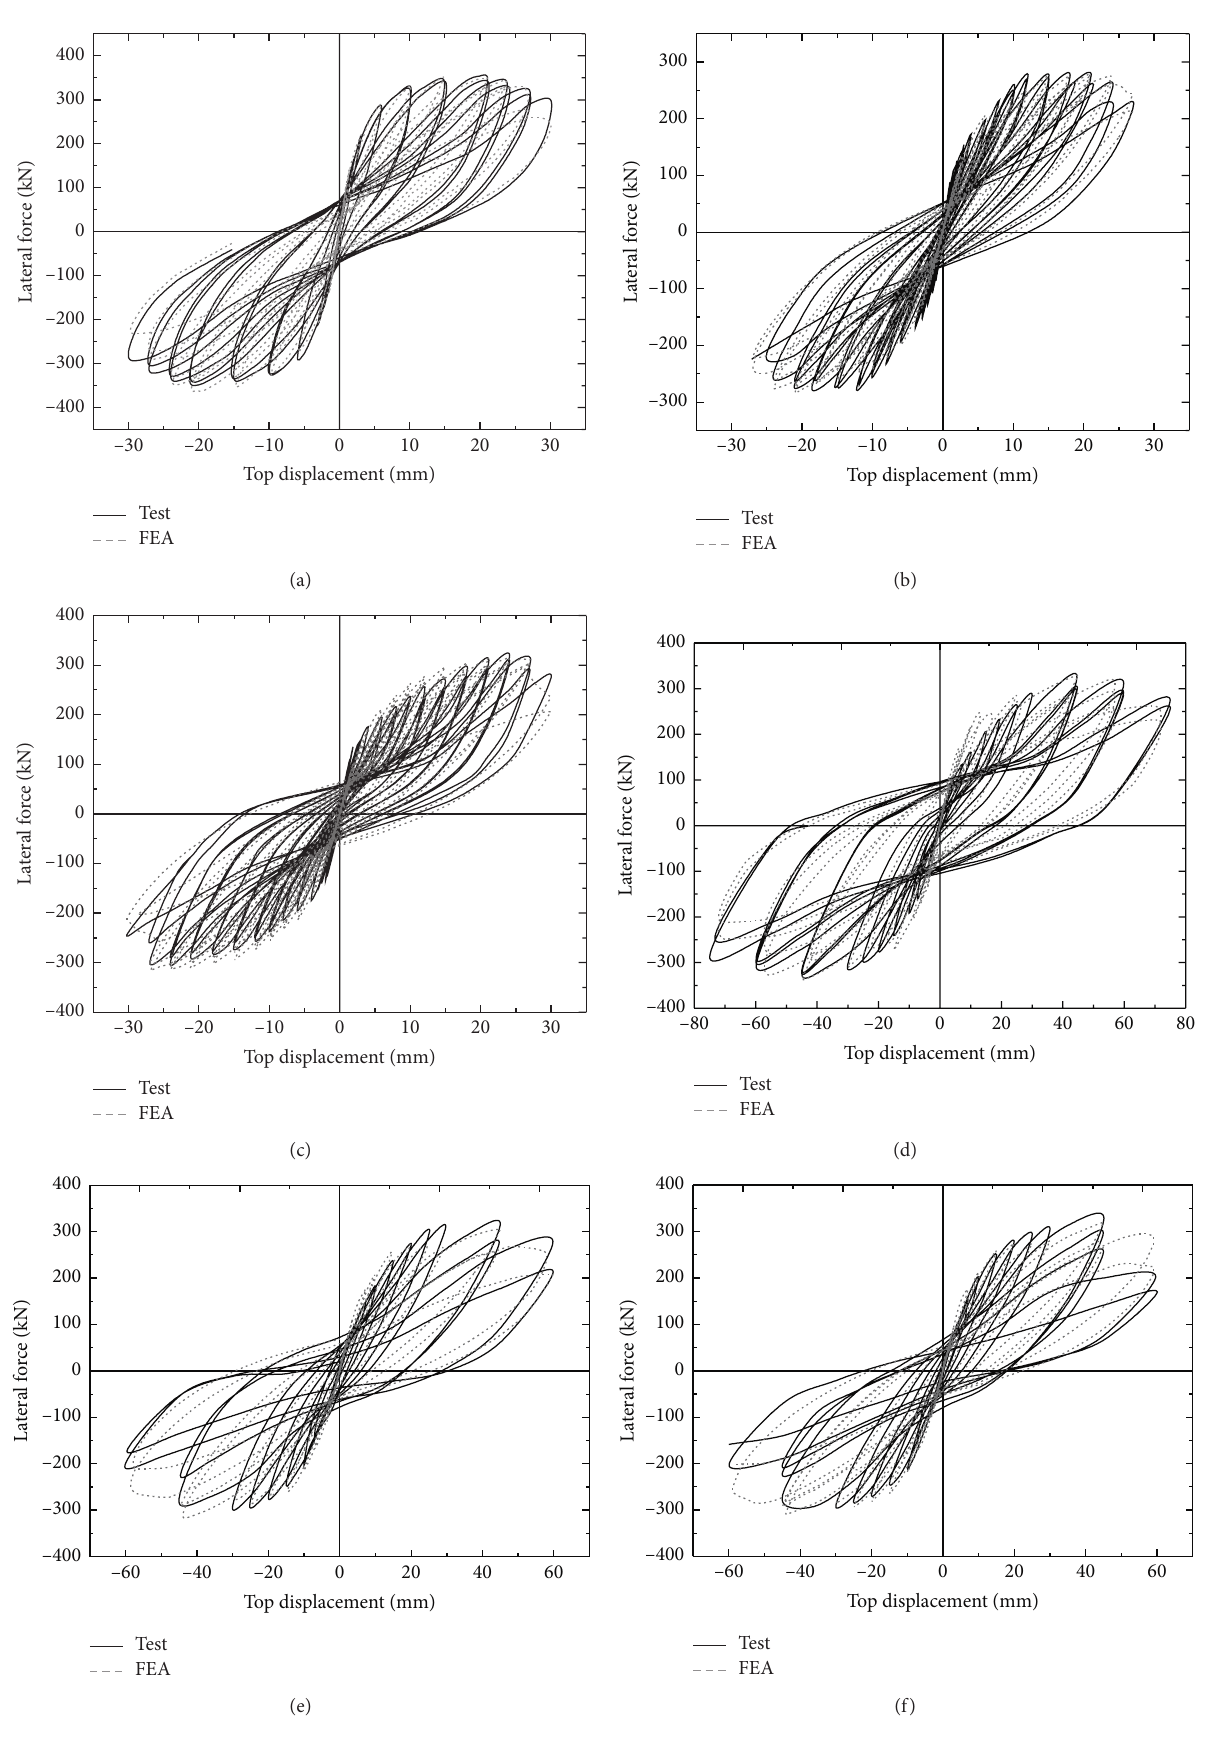
Figure 9: Hysteretic curves. (a) SW1. (b) SRCSW1-1. (c) SRCSW1-2. (d) SW2. (e) SRCSW2-1. (f)